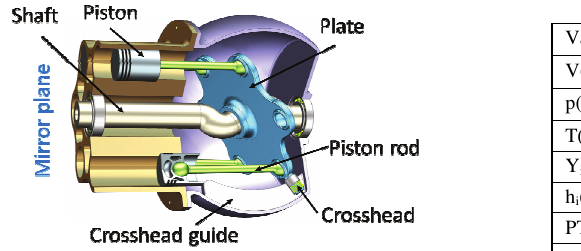
Fig. 4. PAMAR-4 wobble plate (blocked by crosshead, half of the engine)